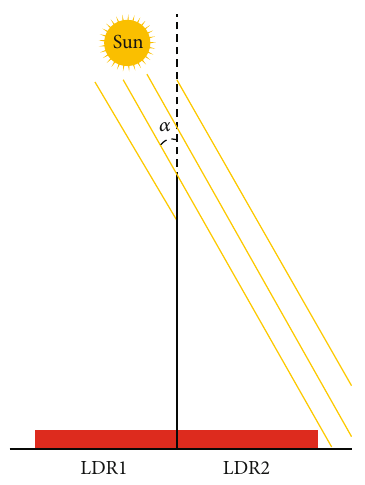
Figure 28: The length of the LDR sensor